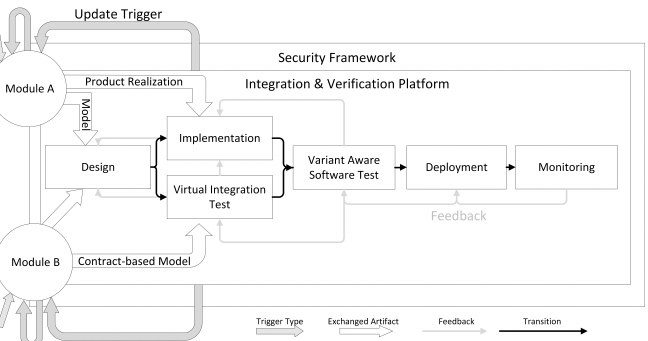
Figure 1. Overarching development, delivery, integration and verification process with overlap- ping